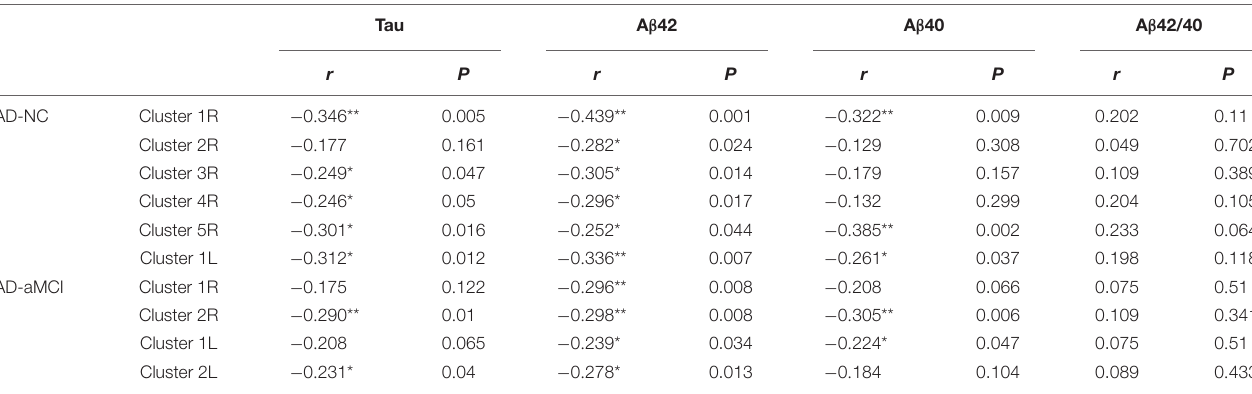
TABLE 5 | Correlation between cortical thickness and plasma A β and